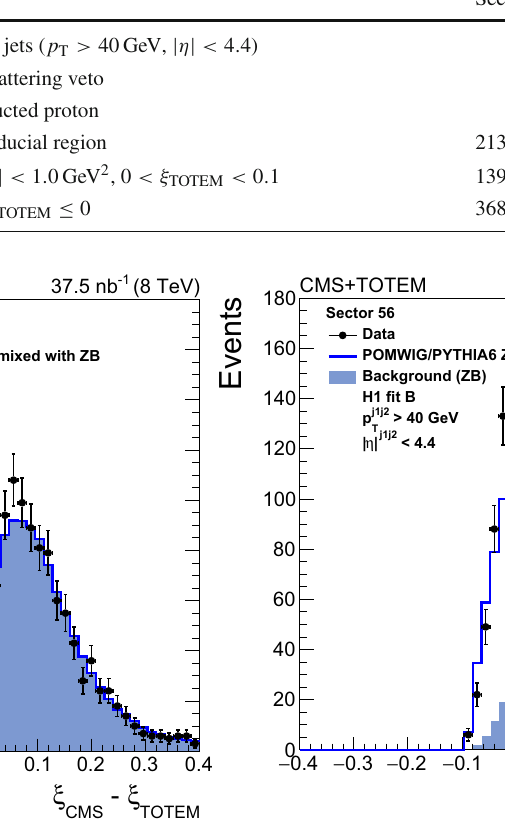
Table 1 Number of events after each selection